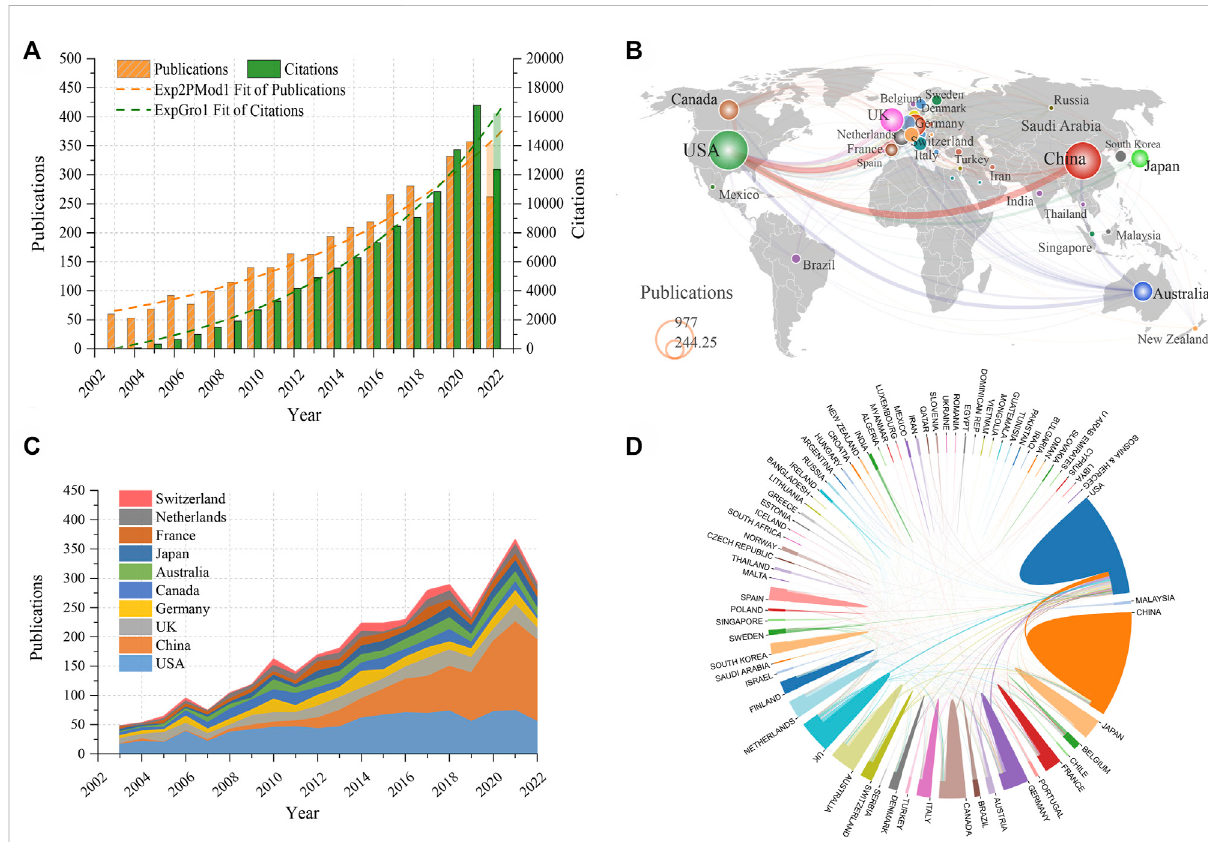
FIGURE 2 (A) Trends in annual citations and publications from 2003 to 2022. (B) World map of the number of publications from each country. The size of the circles represents the number of publications, and the thickness of the lines represents the intensity of cooperation between two countries. (C) Trends in annual publication count in the top 10 productive countries. (D) Network diagram of cooperation among